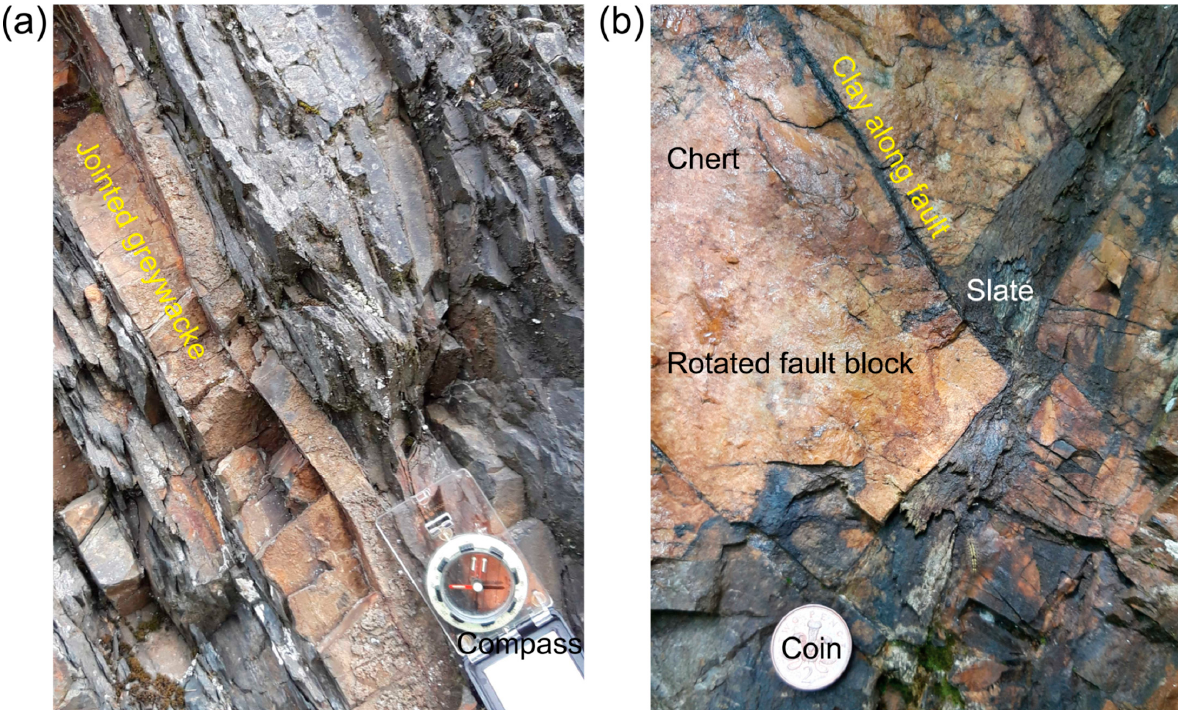
Figure 5. Examples of fractures in Carboniferous greywackes, cherts and slates in the Harz Mountains. ( a ) Joints (cohe- sionless) in thinly-bedded greywackes and slates at Okerstausee, Niedersachsen. ( b ) Example of cohesional fractures at Lautenthal, Niedersachsen. Clay has been injected along faults with centimetre-scale displacements, related to block rotation in a chert bed accommodated by thickness variations in a slate layer.